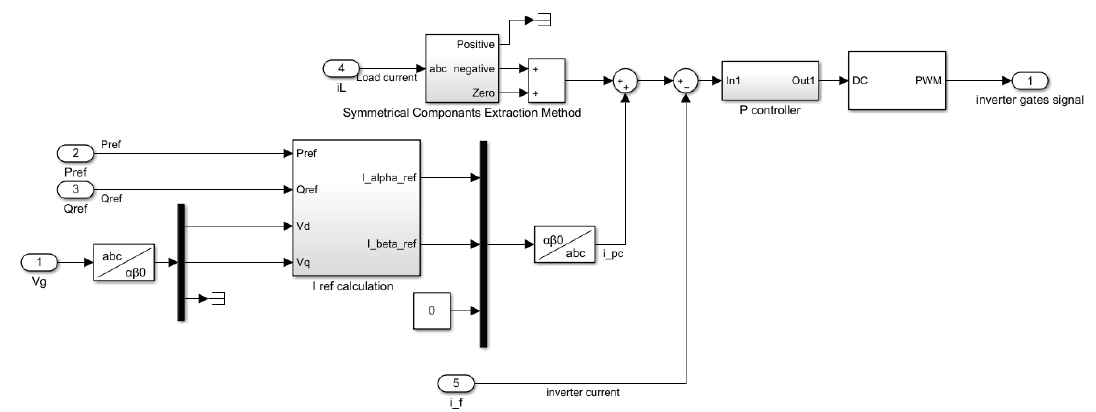
Figure 6. The complete block diagram of the proposed